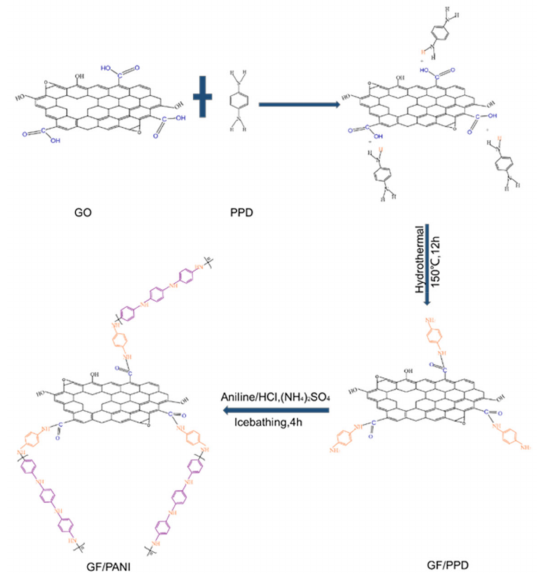
Figure 9. Mechanism diagram of p -phenylenediamine modified